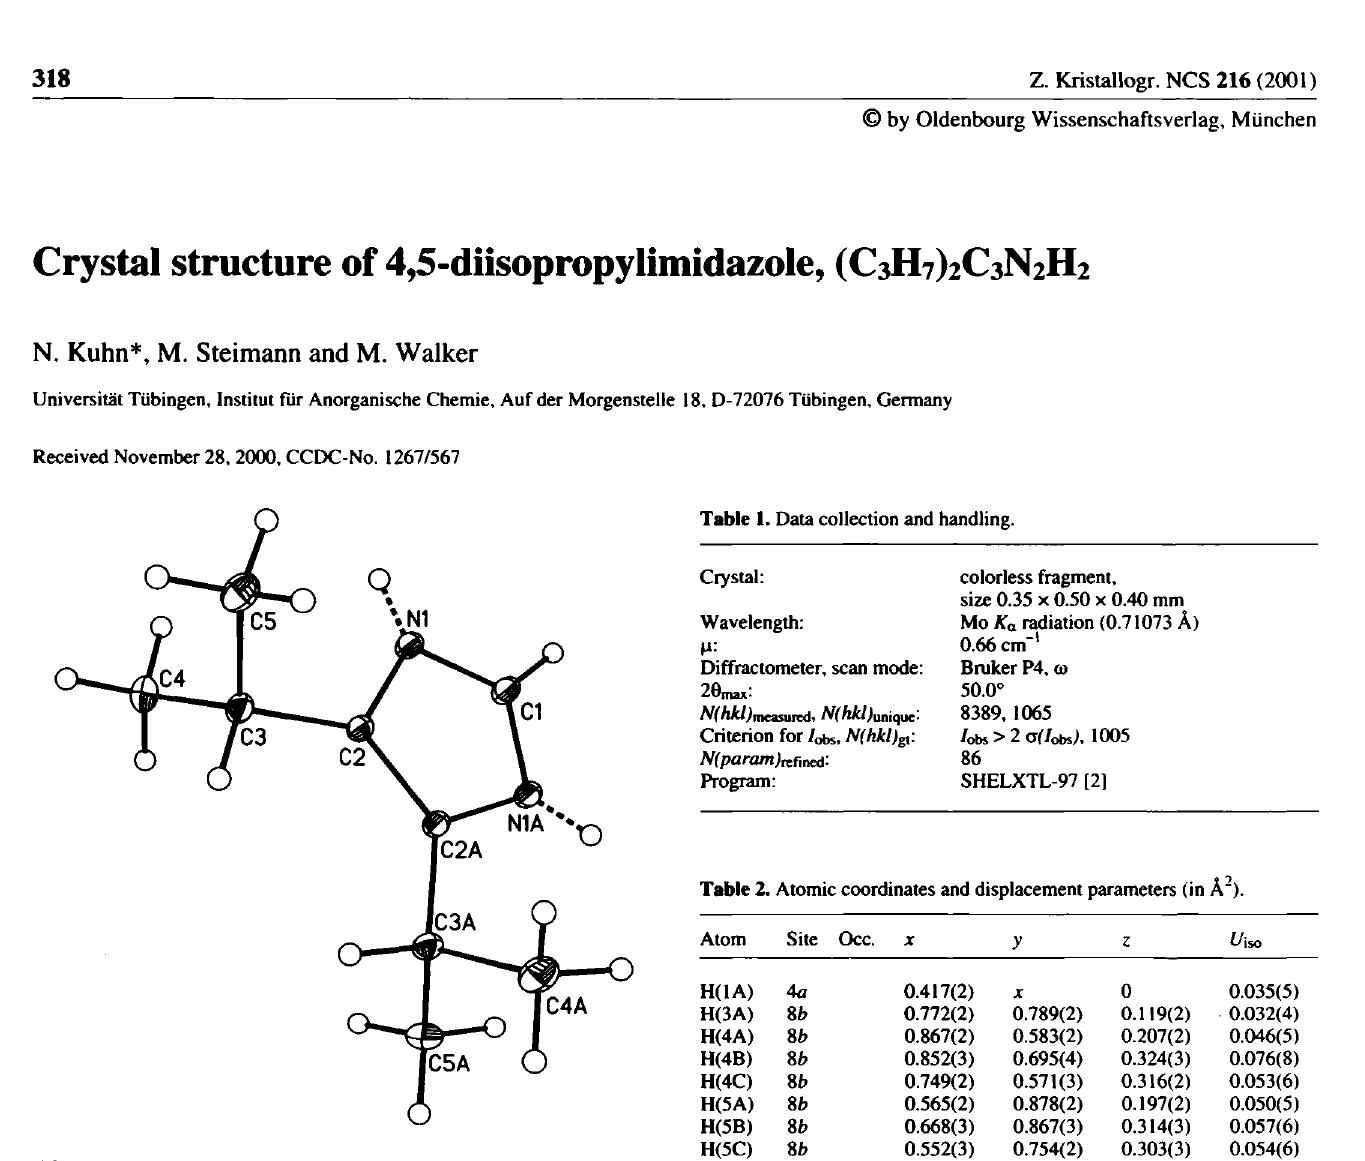
Table 2. Atomic coordinates and displacement parameters (in Ä 2 ).